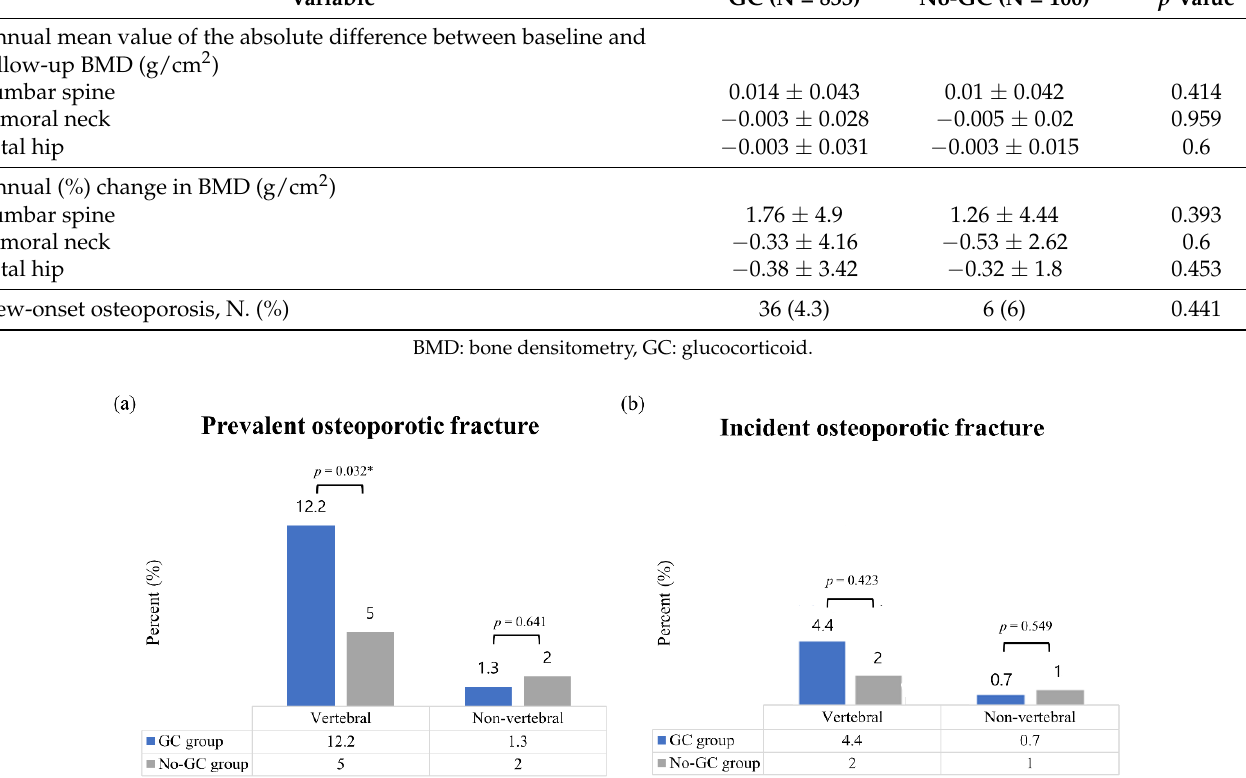
Table 3. Annual change in BMD and new-onset osteoporosis rates between the GC users and the control group. Variable